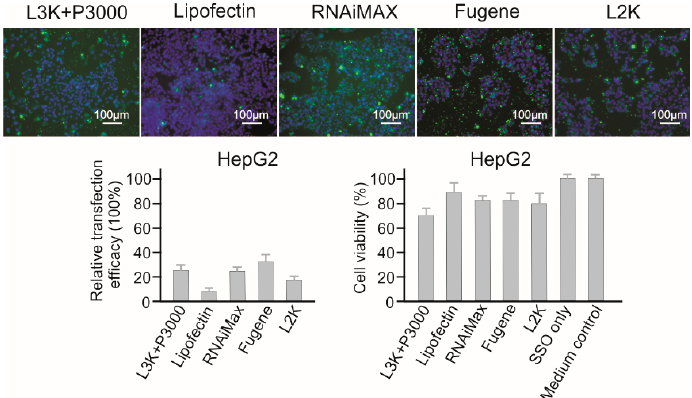
Figure 5. In vitro transfection efficiency and cytotoxicity of different transfection reagents in HepG2 cells. L3K: Lipofectamine 3000, L2K: Lipofectamine 2000.